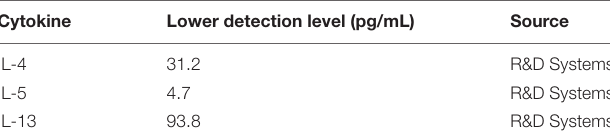
TABLE 3 | The lower detection limits for ELISA. Cytokine Lower detection level